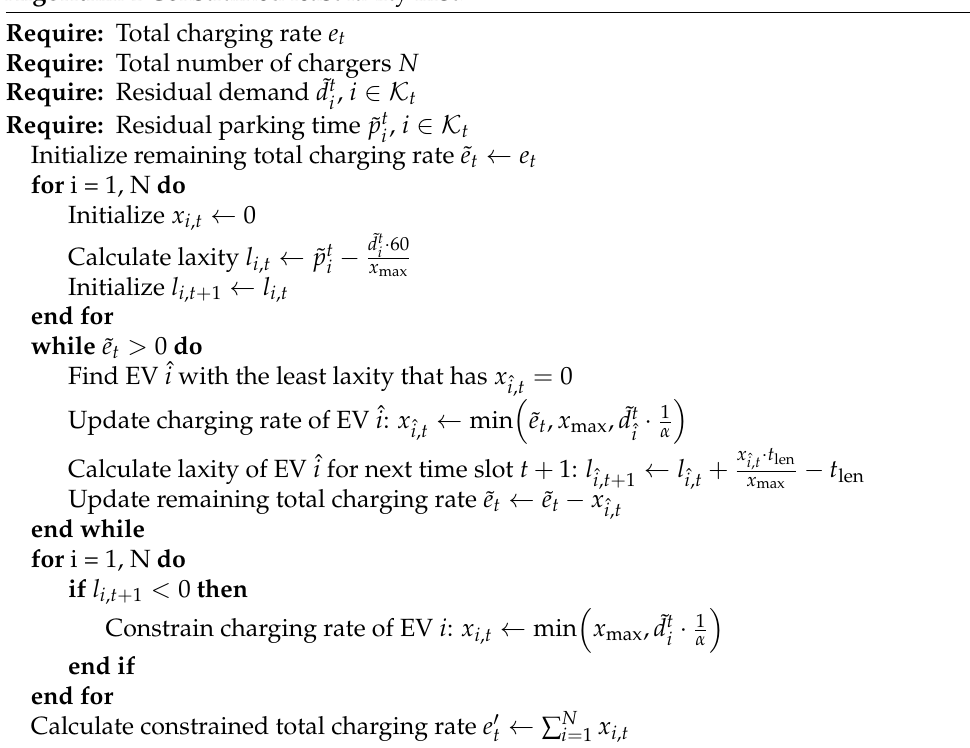
Algorithm 1 Constrained least laxity